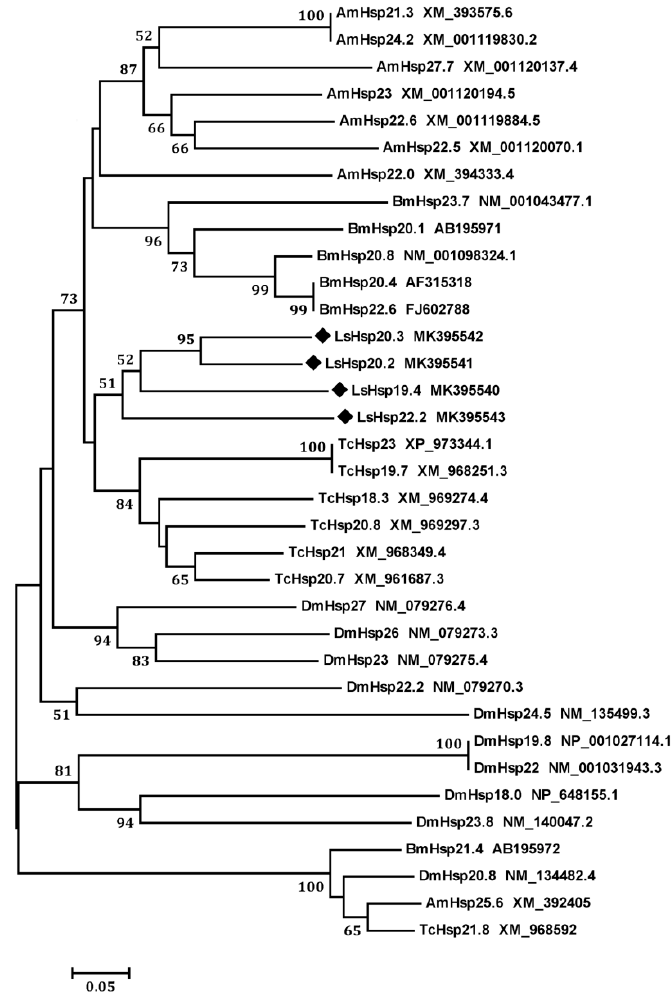
Figure 2. Phylogenetic analysis of small heat shock proteins (sHsps) in L. serricorne and other insects. The tree was generated with MEGA6.06 using the neighbor-joining method. Nodes with > 50% bootstrap values (1000 replications) are indicated on branches. The following insect sHsp sequences were used: Apis mellifera (Am), Bombyx mori (Bm), Drosophila melanogaster (Dm), Lasioderma serricorne (Ls), Tribolium castaneum (Tc). The GenBank accession number for each sequence is specified in the terminal label. The sHsp sequences determined in this study are labeled with a black diamond.